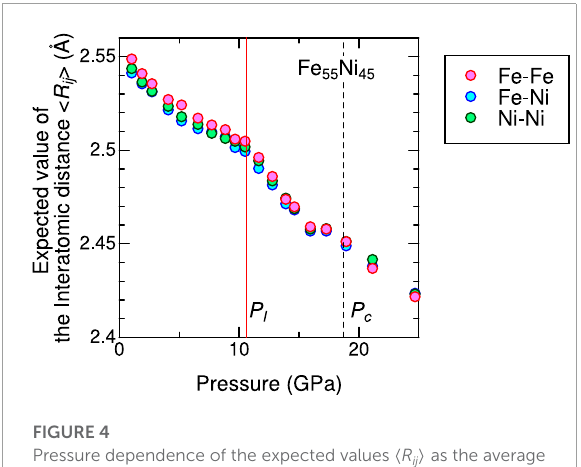
FIGURE 4 Pressure dependence of the expected values ⟨ R ij ⟩ as the average length of 1NN bonds integrated within the entire first shell. Details are described in the